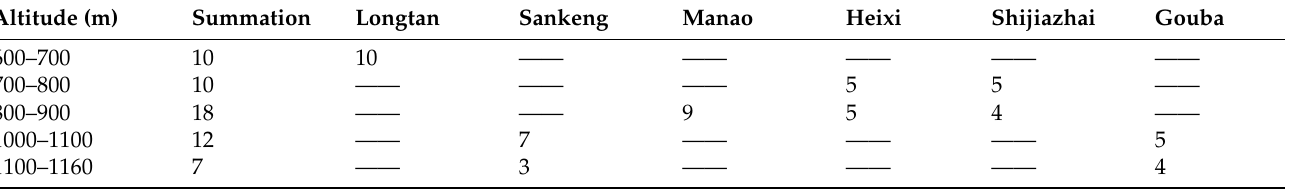
Table 2. The number of targeted microhabitats and classifications under different altitude